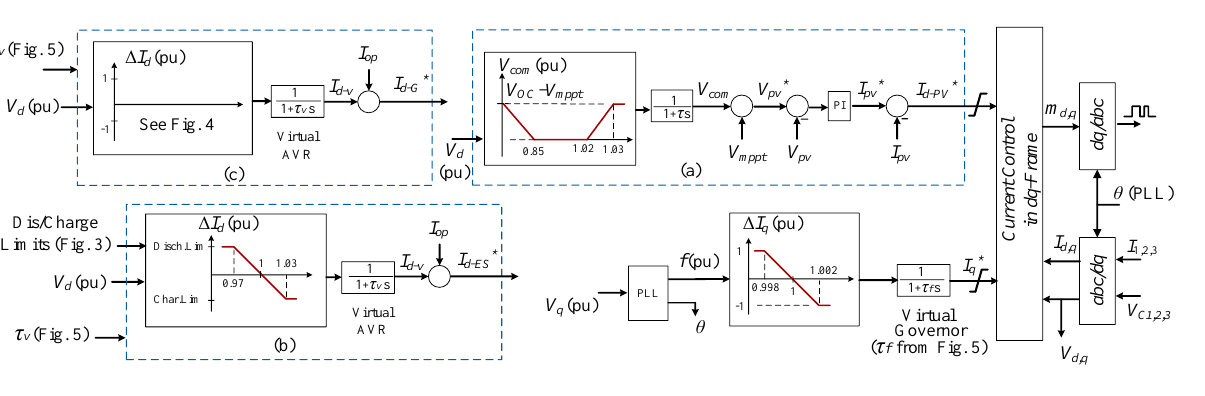
Figure 2. The control scheme applied to all source units. ( a ) Active power control used for PV control, ( b ) control scheme for ES units and ( c ) control scheme for the MGSCs .